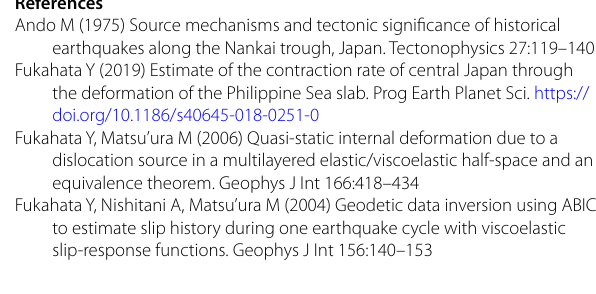
6.8 to 3.7 nanostrain/year. − − , the (cid:31) 3.7 −